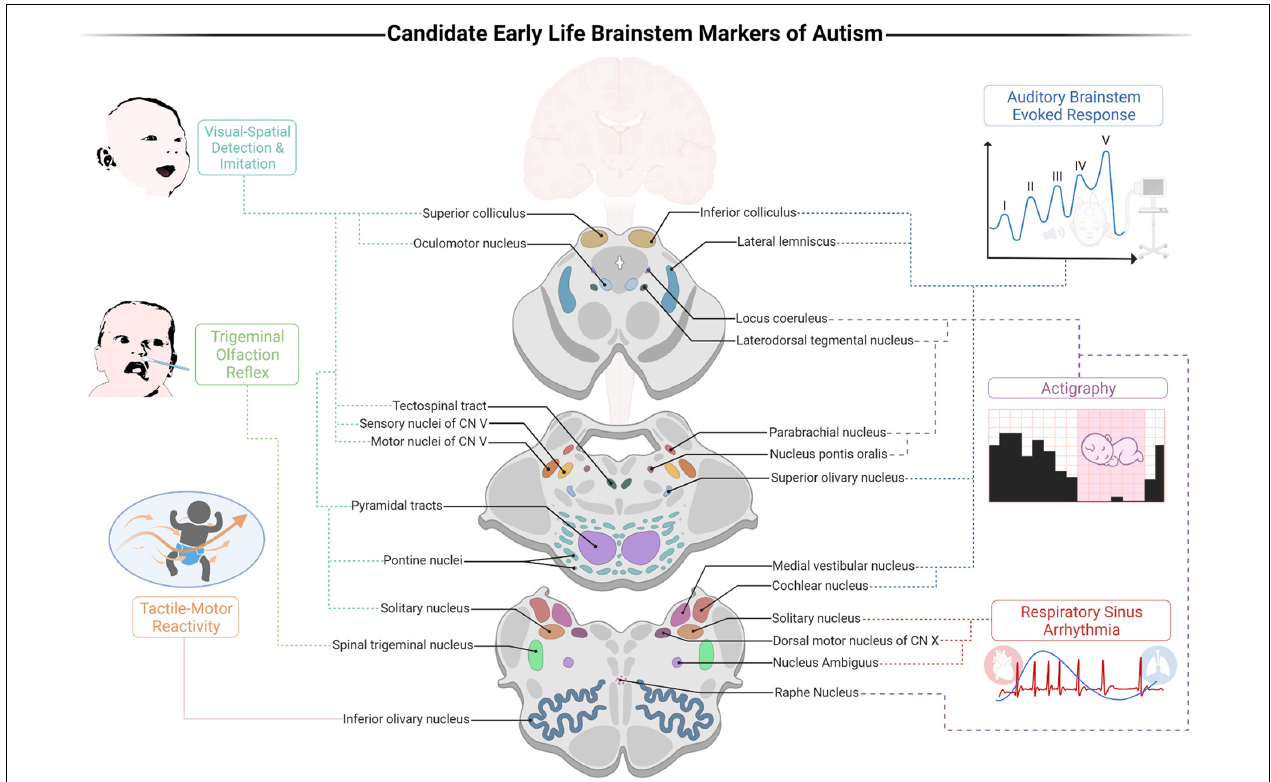
FIGURE 1 | A proposed brainstem-informed autism framework (BIAF) screener for identification of early risk for autism spectrum disorders (ASD). Illustration of the links between the suggested markers and their brainstem substrates. Auditory processing is weighed by the auditory brainstem evoked response (ABR) test (specifically, a delayed V peak latency); DSW: near birth. Control of arousal is weighed by the cardiorespiratory index of respiratory sinus arrhythmia (RSA); developmental screening window (DSW): 0–12 months. Olfaction processing is weighed by the trigeminal olfaction reflex (disgust response following exposure to noxious odorants); DSW: 0–2 months. Sleep-wake regulation is weighed by actigraphy indices ( e.g. , sleeping duration and sleep efficiency); DSW: 1–4 months. Visual processing and gaze are weighed by the abilities to detect and imitate emotional resonating facial expressions; DSW: 1–6 months. Tactile-motor integration is weighed by indices of response thresholds following tactile stimulation; DSW: 1–12 months. Created with